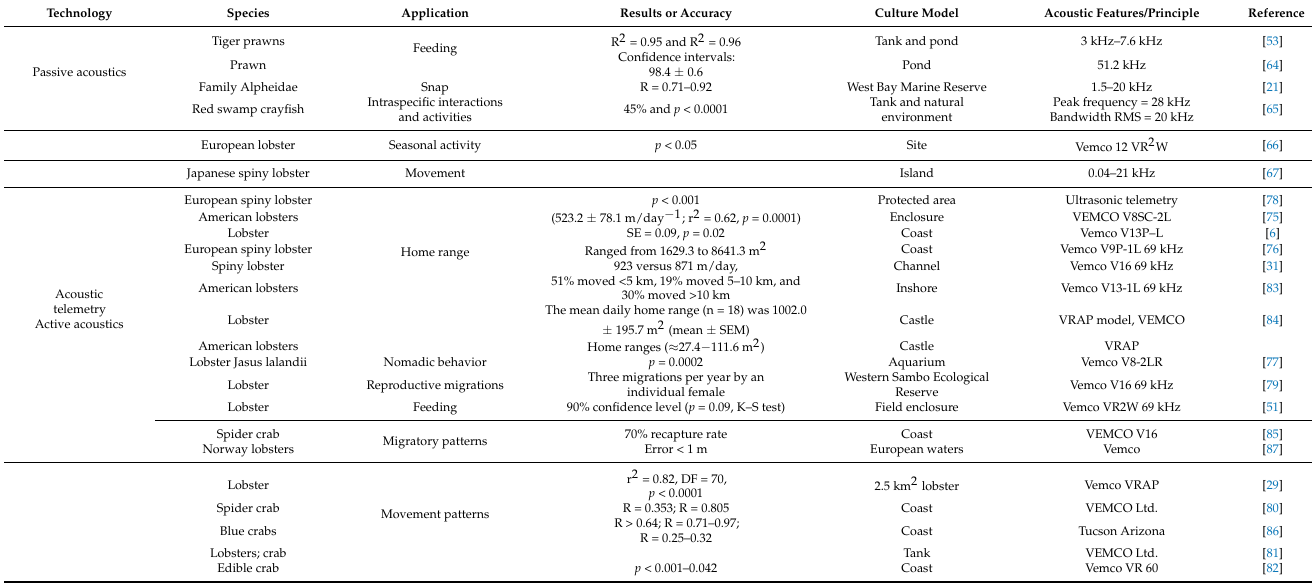
Table 1. Detailed information for behavior monitoring by acoustic